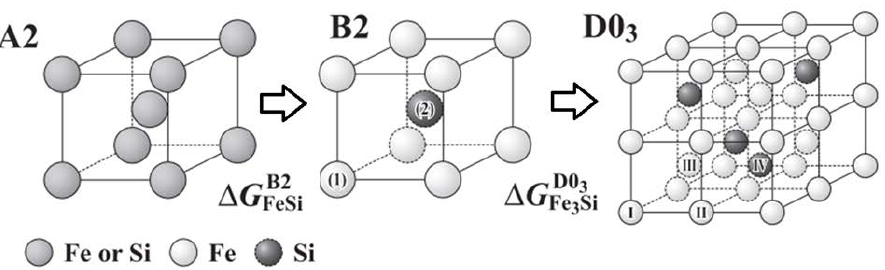
Figure 10. Atomic configurations of bcc phase, disordered A2, and ordered B2 and D03 (the image is reconstructed from [33]).